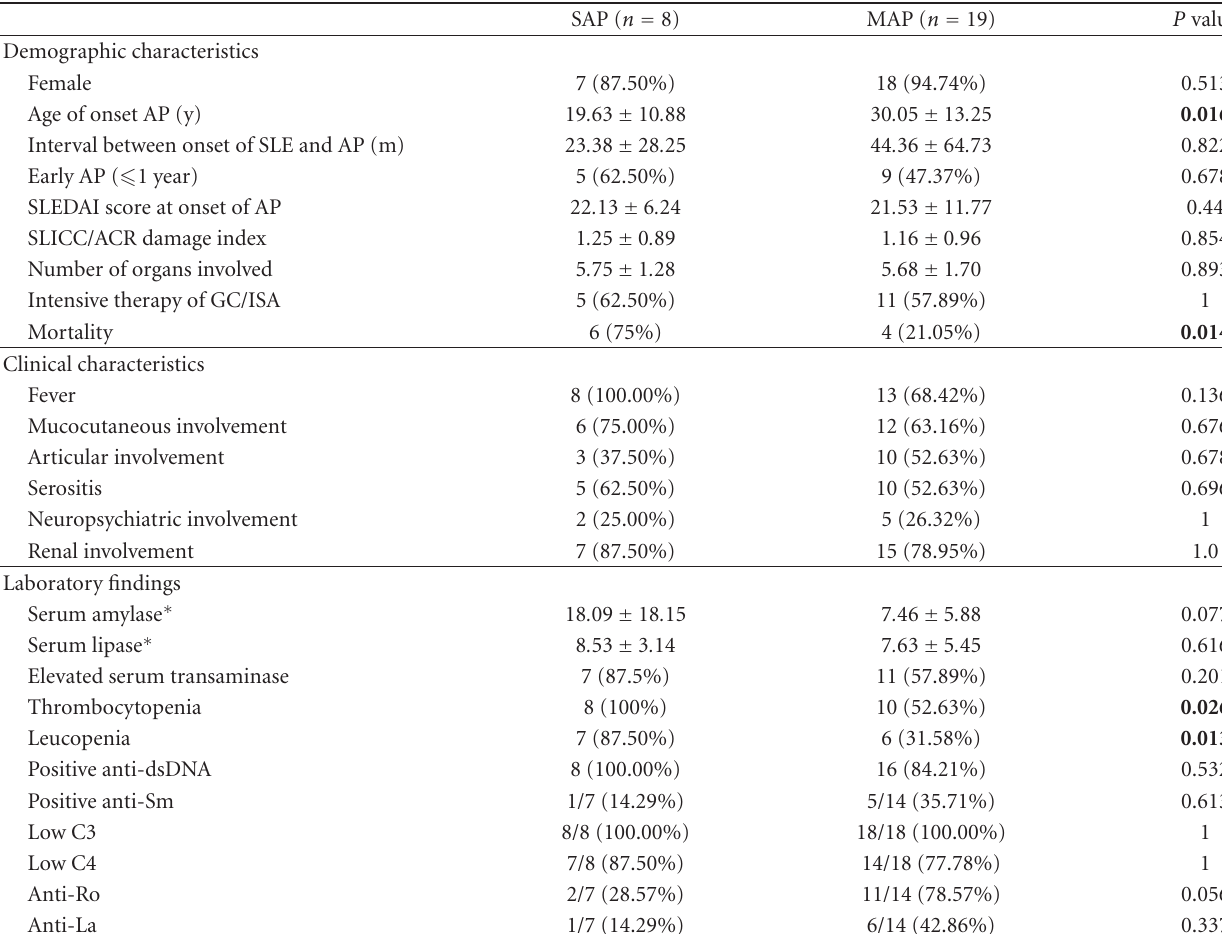
Table 3: Comparison of demographic and clinical characteristics between SLE-related severe acute pancreatitis (SAP) and mild acute pancreatitis